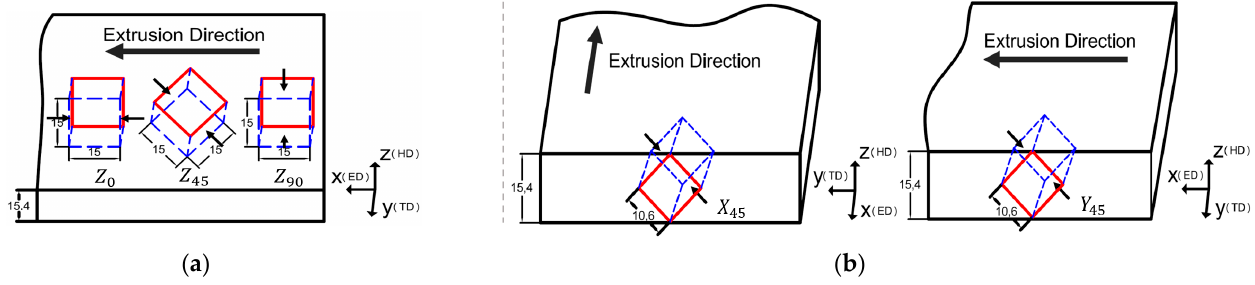
Figure 6. Orientations of specimens and loading directions for upsetting test: ( a ) 15 mm cube specimens ( Z 0 , Z 45 , Z 90 ), ( b ) 10.6 mm cube specimens ( X 45 , Y 45 ) .